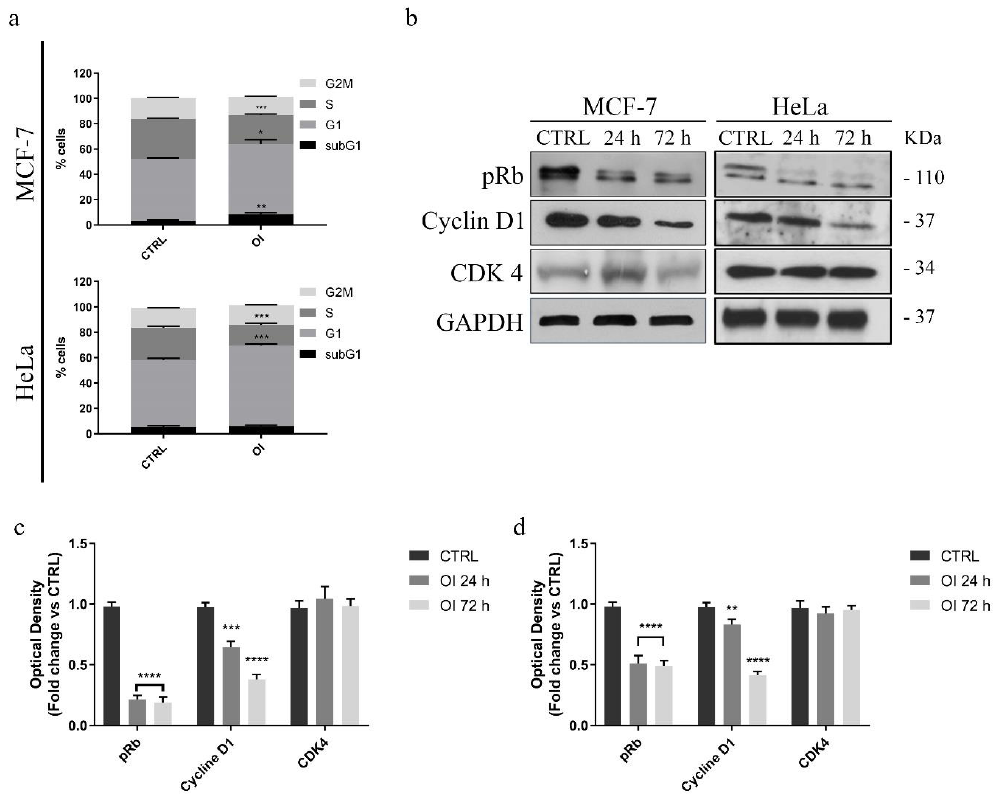
Figure 2. E ff ects of the compound OI on the cell cycle progression in cancer cells. ( a ) Quantitative analysis of the percentage of cells arrested in di ff erent phases of the cell cycle was indicated. Immunoblot and densitometric analyses of several controlling proteins of the G1 / S phase transition in MCF-7 ( b ) and HeLa ( c , d ) treated cells. GAPDH was used as a loading control. Histograms represent means ± SD of three di ff erent experiments in which band intensities were assessed as optical density arbitrary units (OD), and expressed as fold change vs. control samples (CTRL). It is noteworthy that OI treatment impairs the G1 / S transition of both cancer cell lines. * p value < 0.05; ** p value < 0.01; *** p value < 0.001; **** p value < 0.0001.